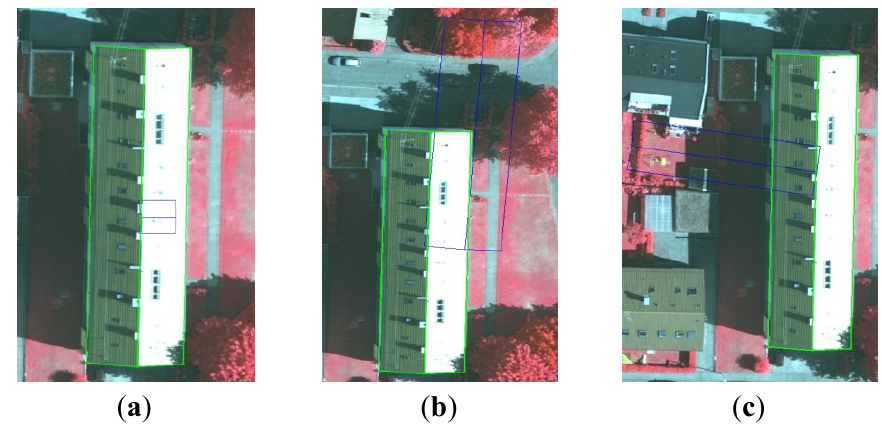
Figure 16. Wireframes of the initial models and the optimized models. ( a ) Scheme I; ( b ) Scheme II; ( c ) Scheme III.